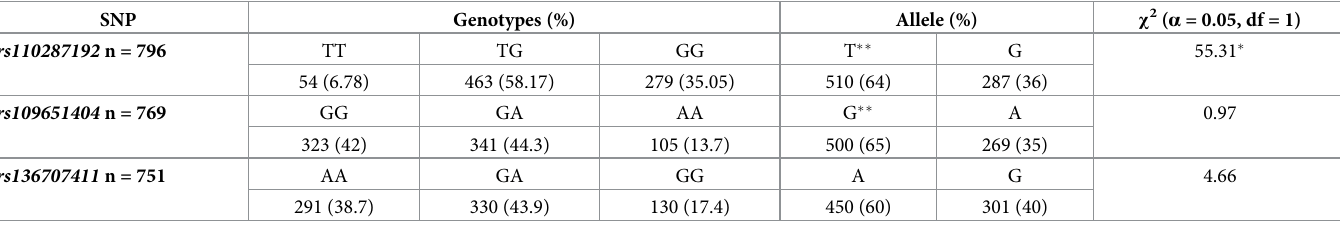
Table 2. A significant association with the pTB was found for the EDN2 rs110287192 variant Table 1. Genotype and allele distribution of the selected SNPs in animals with pTB and controls.